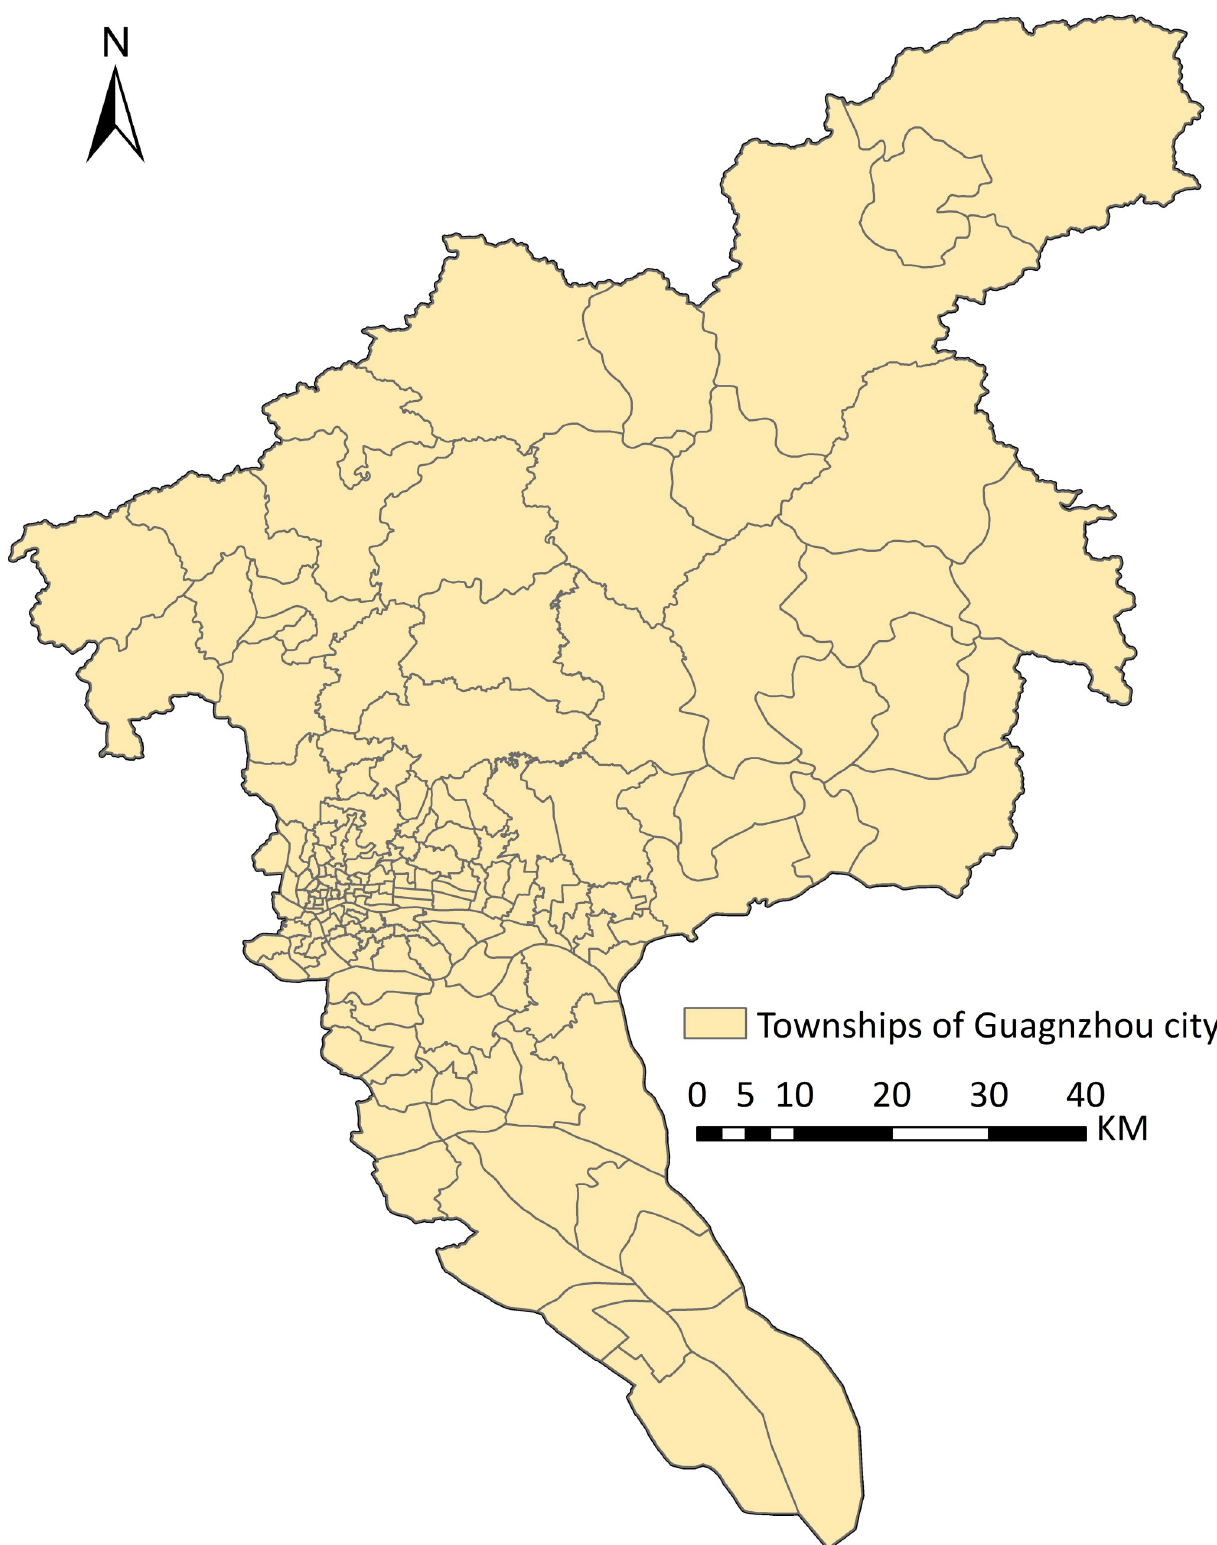
Fig 1. Study area. The 167 townships of Guangzhou City.